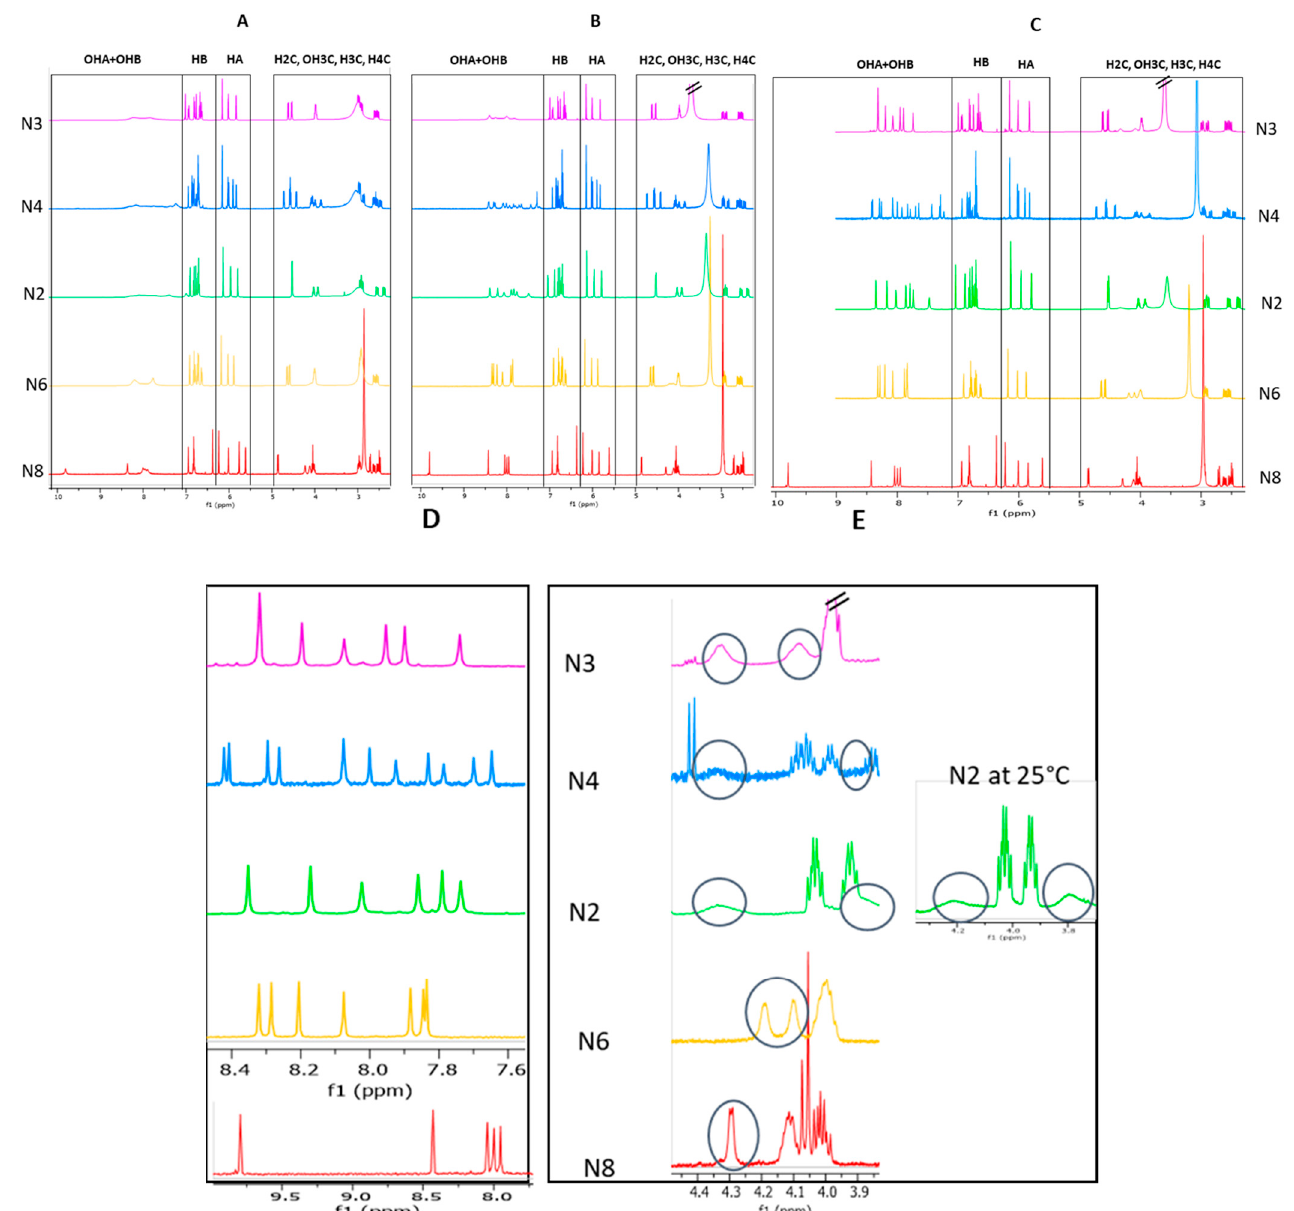
Figure 2. Image of 1D 1 H spectra of the fractions N2, N3, N4, N6, and N8 at 25 ◦ C, solubilized in acetone- d 6 ( A ), at 25 ◦ C in acetone- d 6 in the presence of cadmium ( B ), at 15 ◦ C in acetone- d 6 in the presence of Cd (with an additional step consisting in dryness evaporation of the fractions N2, N3, and N4) ( C ), expansion of the phenolic ( D ) and the aliphatic ( E ) OH regions in the same physicochemical conditions as in ( C ).